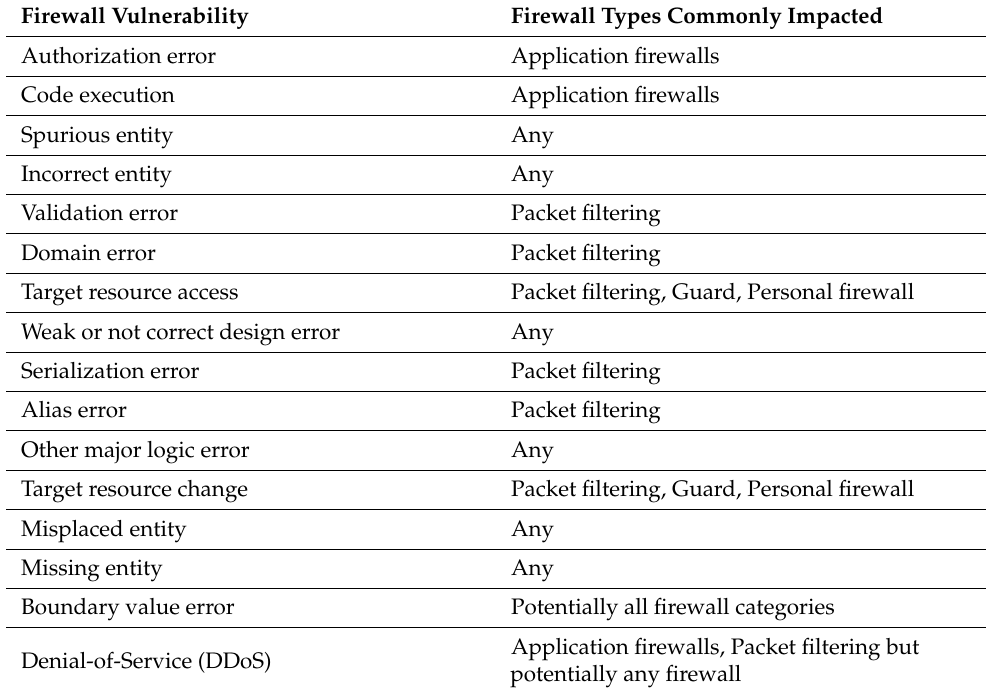
Table 2. List of most known firewall vulnerabilities and targeted firewall